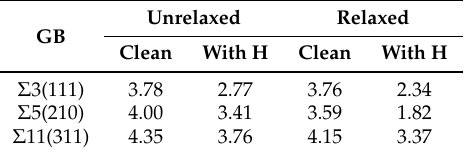
Table 3. Work of separation (in J/m 2 ) calculated for Σ 3, Σ 5, and Σ 11 GBs with and without hydrogen. Unrelaxed Relaxed GB Clean With H Clean With H Σ 3(111)